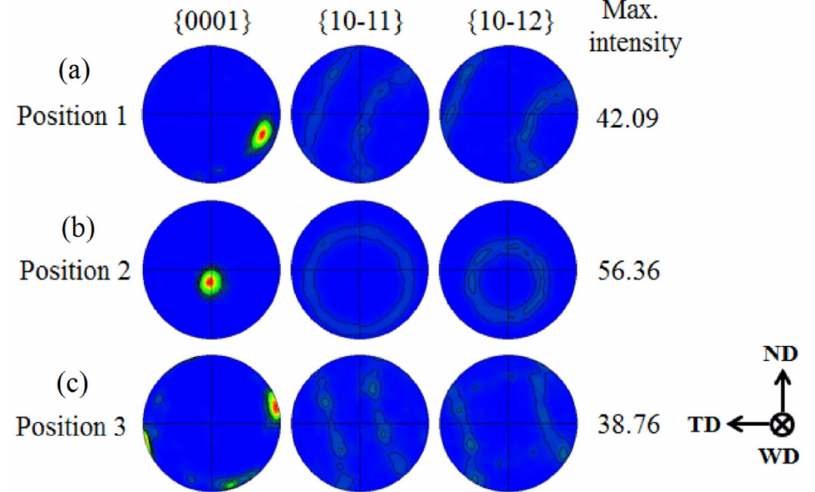
Figure 4. Pole figures in di ff erent zones ( a ) position 1 ( b ) position 2 ( c ) position 3 of the FSWed AZ31 Mg alloy